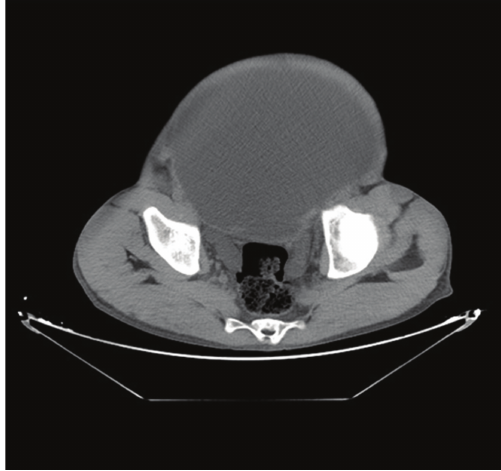
Figure 2: Caudal pelvic CT scan showing a huge urinary bladder.